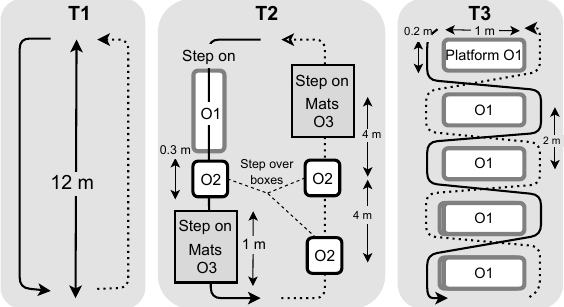
Figure 3. Walking tracks of UDS walking tests. The subjects were walking continuously on the full arrow and coming back following the dotted arrow. T1 was a normal straight walk without